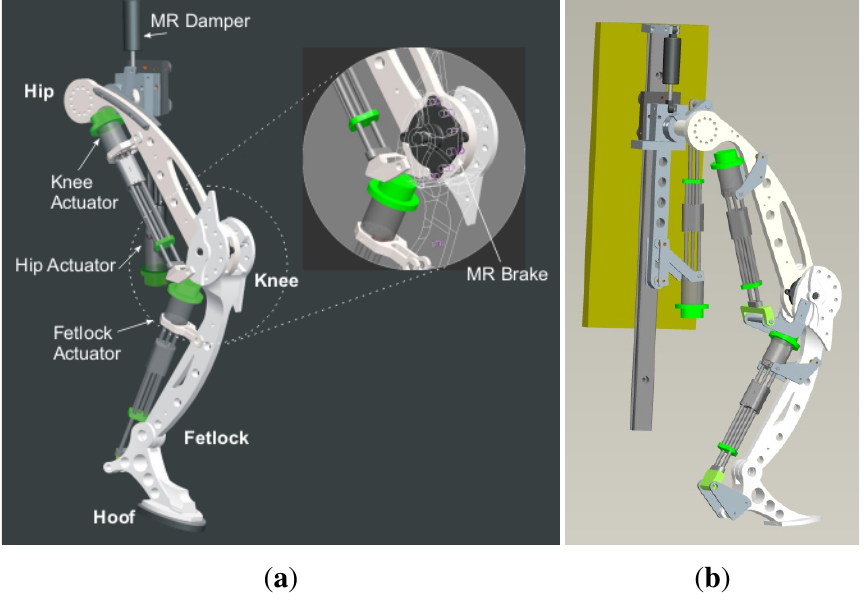
Figure 12. Design of first prototype of the HADE Leg. ( a ) The MR rotary damper at the knee is showed in zoom-in view; ( b ) reverse view of the actuators.